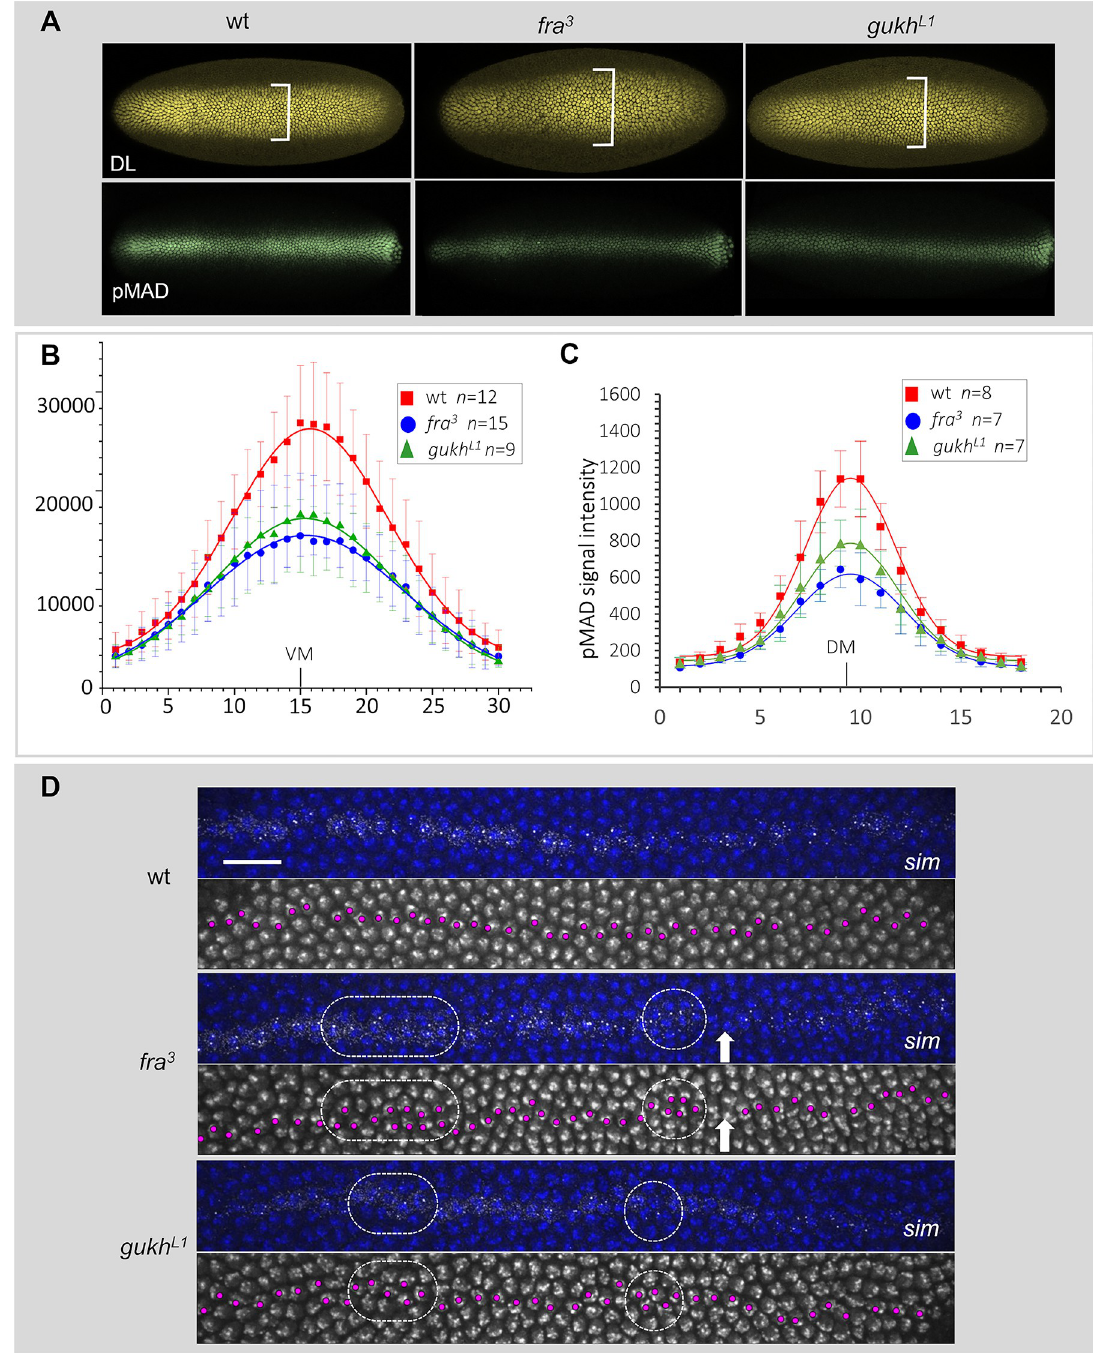
Fig 6. GUKH and FRA modify DL and DPP thresholds levels and displace cells within expression borders. (A–C) Detection and quantification of nuclear DL and pMAD in wild type, fra and gukh . (A) Ventral and dorsal views of mutant and wild-type embryos stained for anti-DL (yellow) and anti-pMAD (green) antibodies. (B) DL gradient quantification shows lower peak in fra (blue) and gukh (green) than in wild type (red). VM, ventral midline. (C) pMAD gradient decreases in amplitude in both mutants. DM, dorsal midline. Error bars, standard deviation; n, sample sizes. (D) Mesectodermal border is disrupted in fra and gukh . sim RNA in late-stage embryos stained with Hoescht (gray and blue in alternating panels). Magenta dots, sim+ nuclei. Wild-type sim pattern forms a straight single-cell row. sim expression is interrupted in fra (arrows) and forms clusters in both fra and gukh (dashed lines) (see also S7 Fig). Scale bars, 60 μ m (A) and 20 μ m (D). Metadata for the graphs shown in B and C can be found at Supporting information S1 Metadata. DL, dorsal; DPP, decapentaplegic; FRA, frazzled; GUKH, guk-holder; p-MAD, phosphorylated-Mothers Against DPP.